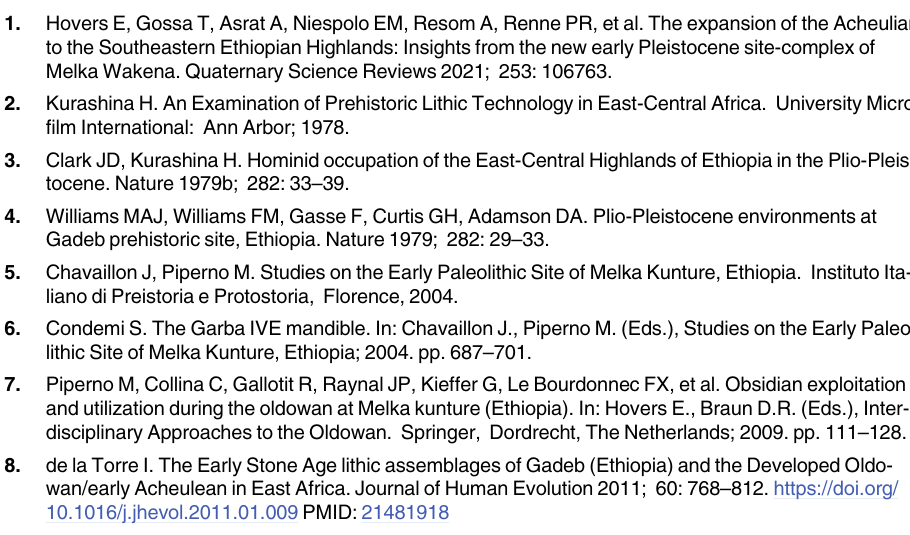
S5 Table. Physical properties of core assemblages from MW2 occupation layers. S6 Table. Physical properties of LCTs from MW2 occupation